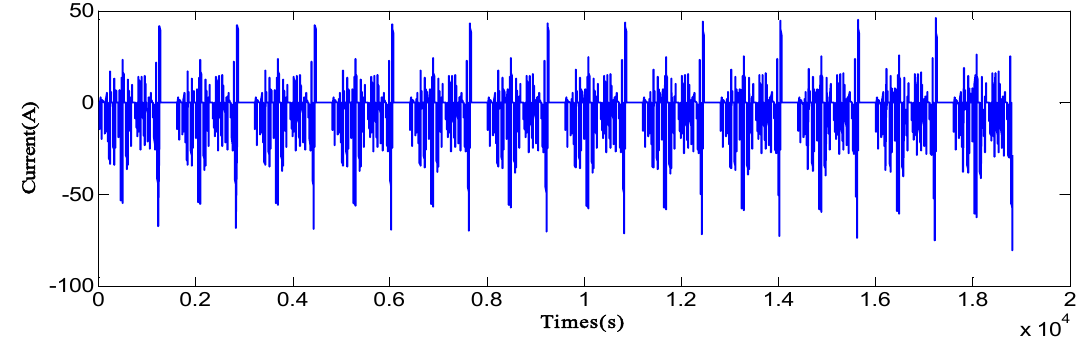
Figure 5. The load current profile during ten BJDC cycles.